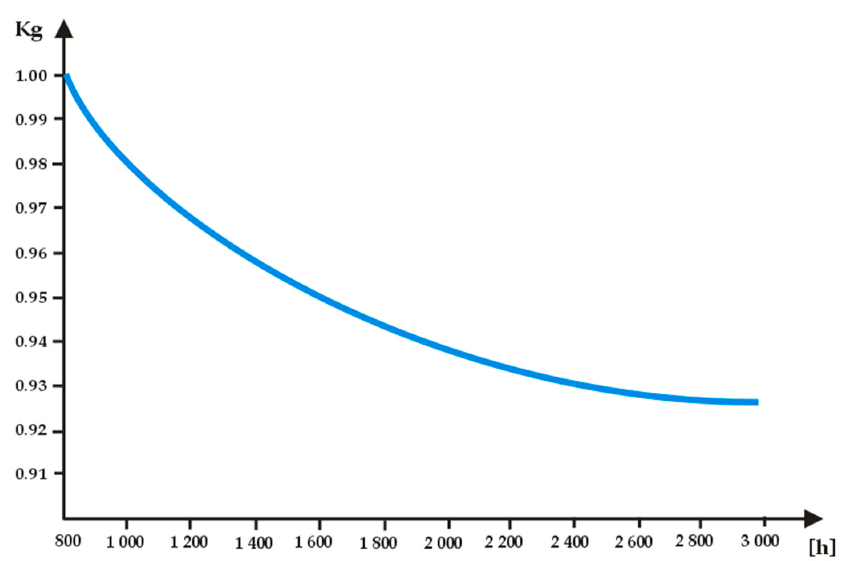
Figure 6. A graph showing the reliability of wind farm equipment in terms of time between break- downs during operation.